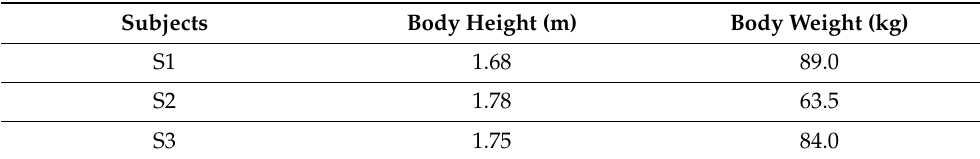
Table 1. The body heights and body weights of three subjects